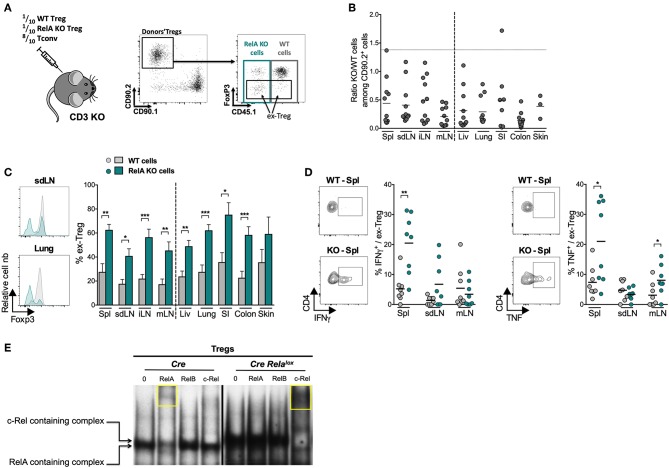
RelA-deficient Tregs are unstable and turn pathogenic. (A–D) Adoptive transfer of a 1:1:8 ratio of a mix of CRE-expressing Tregs from Foxp3Cre/wt (CD45.1/2 CD90.2 WT Tregs), Foxp3Cre/wt
Relalox (CD45.2 CD90.2 RelA KO Tregs) mice and CD4+ conventional T cells (CD90.1 Tconv) into CD3 KO mice and analysis of donor cells 16 days later. (A) Experimental scheme and representative gating strategy from sdLN staining. (B) Ratio of RelA KO to WT Tregs in the indicated organs (spl, spleen; liv, liver; SI, small intestine) among CD90.2+ donor cells. The horizontal dot line represents the initial ratio (in the syringe). (C) Representative histograms and proportion of ex-Tregs from injected WT cells and RelA KO cells in different tissues. (D) Representative density plots and proportions of IFNγ+ and TNF+ cells among WT ex-Tregs and RelA KO ex-Tregs. Each dot represents a mouse, lines and bars show the means of pooled independent experiments. Error bars represent SEM. (E) EMSA combined with supershift assay analysis of NF-κB subunits activation in Tregs isolated from Foxp3Cre (Cre) and Foxp3Cre
Relalox (Cre Relalox) mice. The yellow squares point out the supershift of RelA or c-Rel containing complexes. The results are representative of independent experiments. For mouse and experiment numbers, see Supplementary Table 1. The two-tailed unpaired non-parametric Mann–Whitney U-test was used for data not following a normal distribution and the t-test was used for data following a normal distribution *p < 0.05, **p < 0.01, ***p < 0.001.